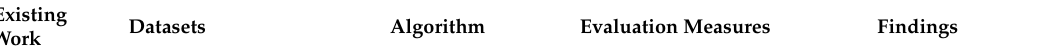
Table 1. Software Effort Estimation